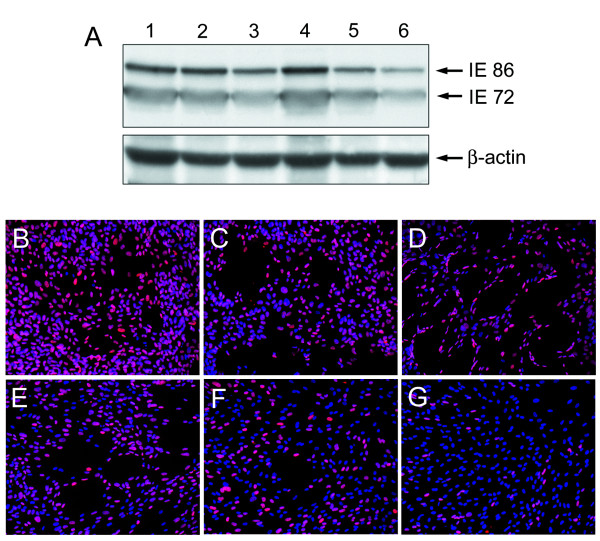
IFN-α, IFN-β and/or IFN-γ inhibit HCMV IE protein expression. (A) HFFs were pre-treated with either vehicle (1) or 100 IU/ml of IFN-α (2), IFN-β (3), IFN-γ (4), IFN-α and IFN-γ (5) or IFN-β and IFN-γ (6) 12 h prior to infection with HCMV. At 12 h p.i., cells were harvested and equal amounts of total protein were examined for IE protein (IE72, IE86) expression by western blot analyses. (B-G) Vehicle- or IFN-treated cells were infected with HCMV and the nuclear proteins IE72/86 were detected by indirect immunofluorescence 5 d p.i. Representative images (100X) from cultures treated with (B) vehicle, (C) IFN-α, (D) IFN-β, (E) IFN-γ, (F) IFN-α and IFN-γ or (G) IFN-β and IFN-γ. Immunofluorescent labeling: HCMV IE72/86 – Alexa Fluor 568 (red), nucleus – DAPI (blue), overlaid (pink).